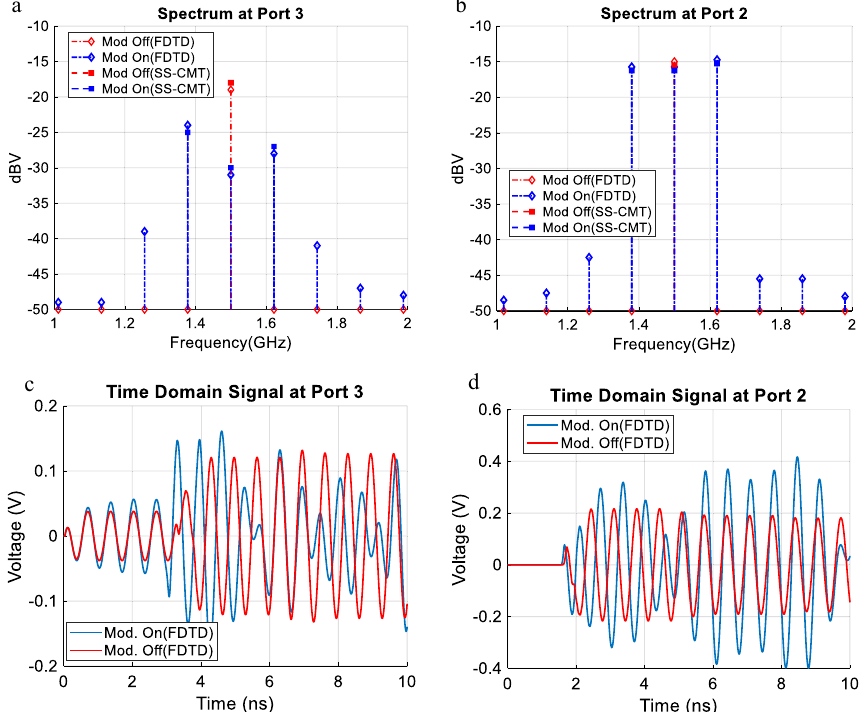
Figure 5. Comparing response of the modulated and unmodulated structure: ( a ) frequency spectrum for port 3 (the near-end crosstalk in line 2), ( b ) frequency spectrum for port 2 (the main signal in line 1), ( c ) time domain signal at port 3 and ( d ) Time domain signal at port 2. Some 12 dB crosstalk reduction is